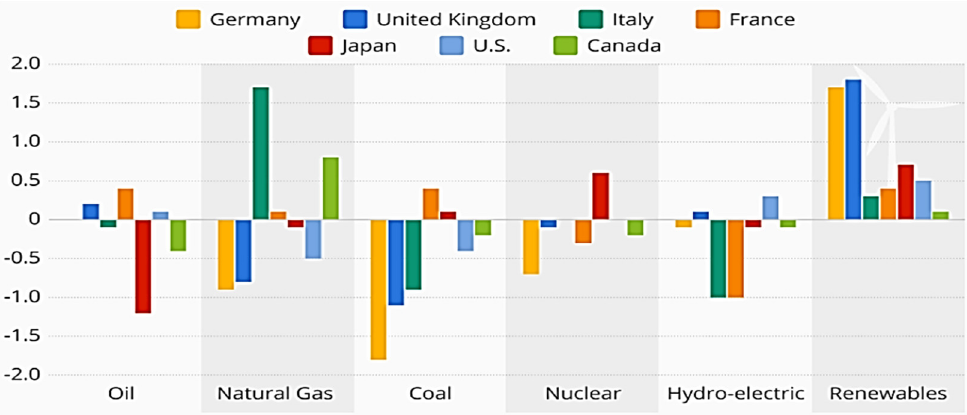
Figure 2. sources of renewable energy in G7 economies (source: Statista 2019). Figure 2. Sources of renewable energy in G7 economies (source: Statista